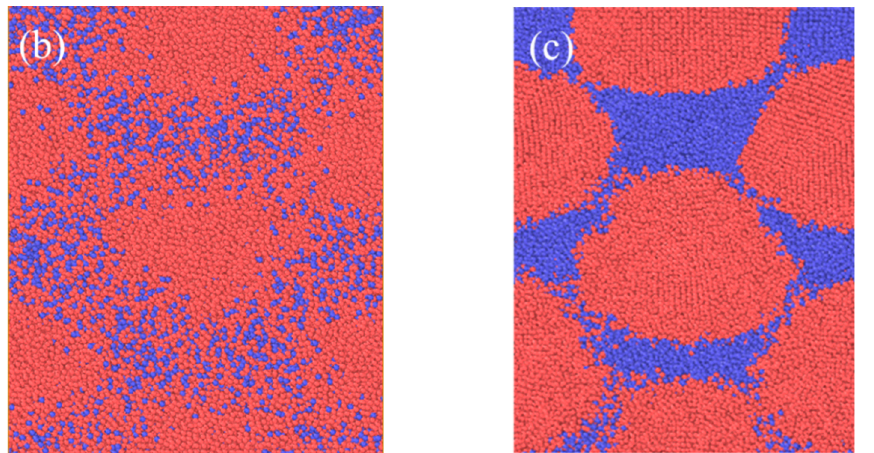
Figure 18. Temperature distribution at different impact speeds: ( a ) is the temperature distribution of the particles; ( b , c ) is the enlarged particle morphology of the arrows in ( a ).